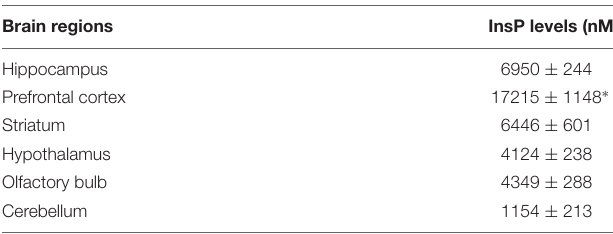
TABLE 1 | Basal levels of endogenous InsP in different brain regions of CD1 mice. Brain